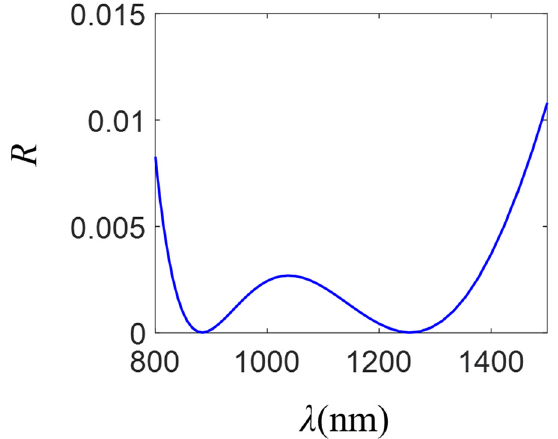
Figure 4. Reflection spectrum for a system comprising two antireflection dielectric layers located on a silicon substrate ( n s = 3.5). Their thicknesses ( t ) and refractive indices ( n ) correspond to t 1 = 185 nm, t 2 = 104 nm and n 1 = 1.396, n 2 = 2.474, respectively. The structure was illuminated by a plane wave propagating along the - z -axis.